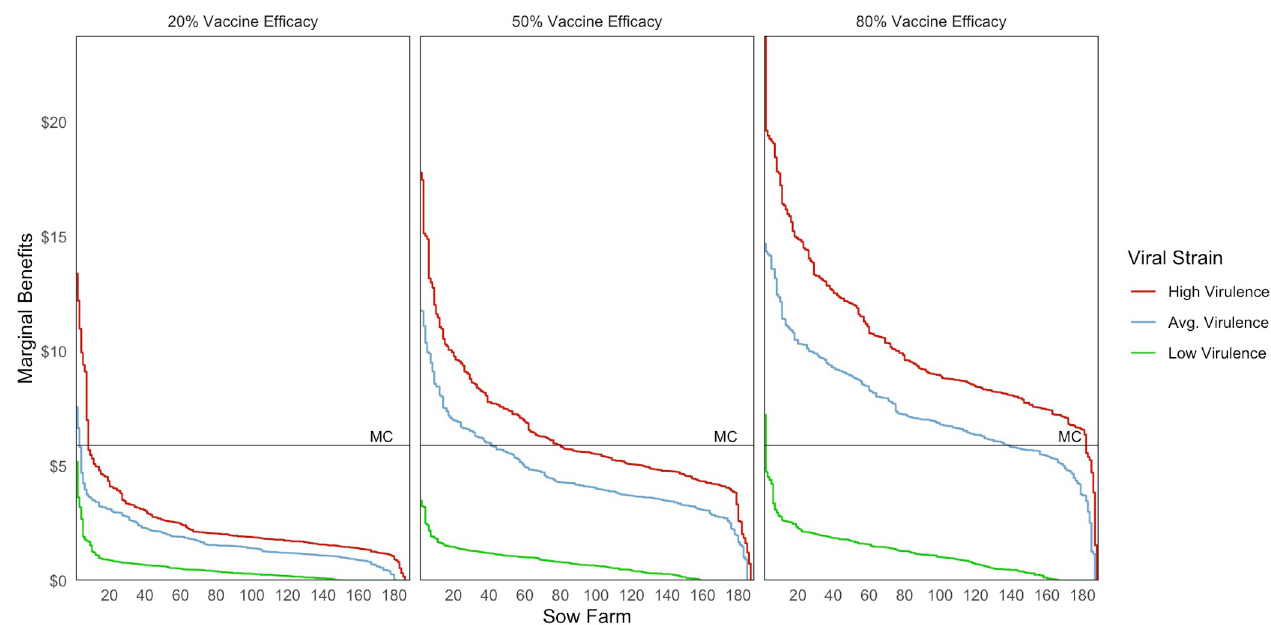
Fig 5. Marginal benefits from individual adoption of vaccination when varying infecting strains and vaccine efficacy. Note: The estimated marginal cost of vaccination (MC) is a constant $5.9/year per animal.